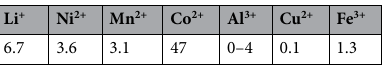
Table 1. Synthetic PLS composition